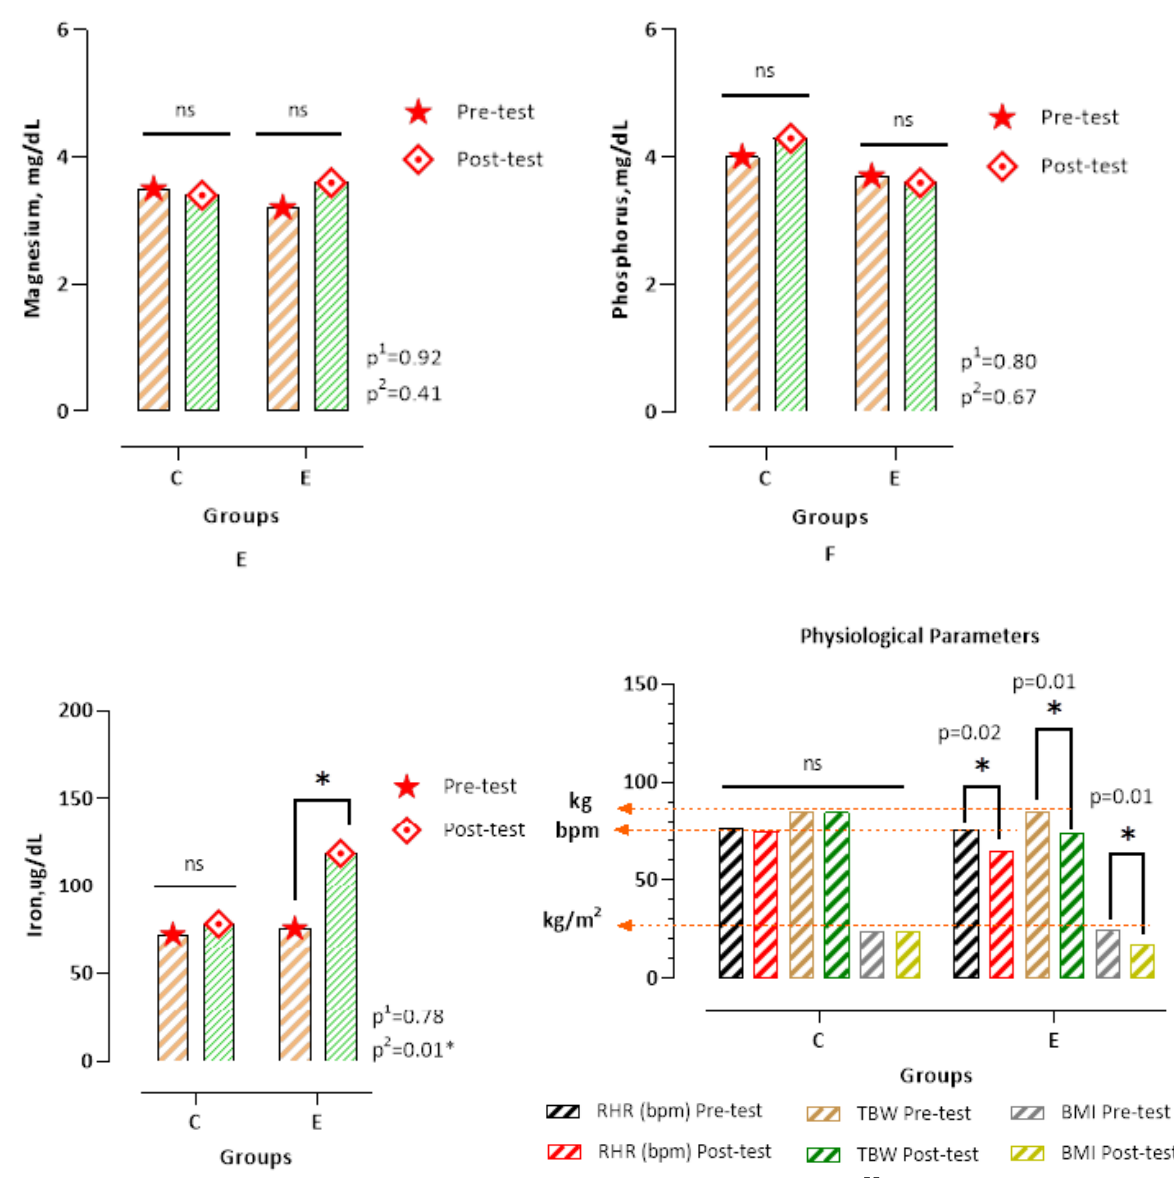
Figure 4. The figure below demonstrates the within-group pre-test/post-test serum elements magnesium, phosphorus, iron, BMI, TBW and RHT (Experimental, Control;